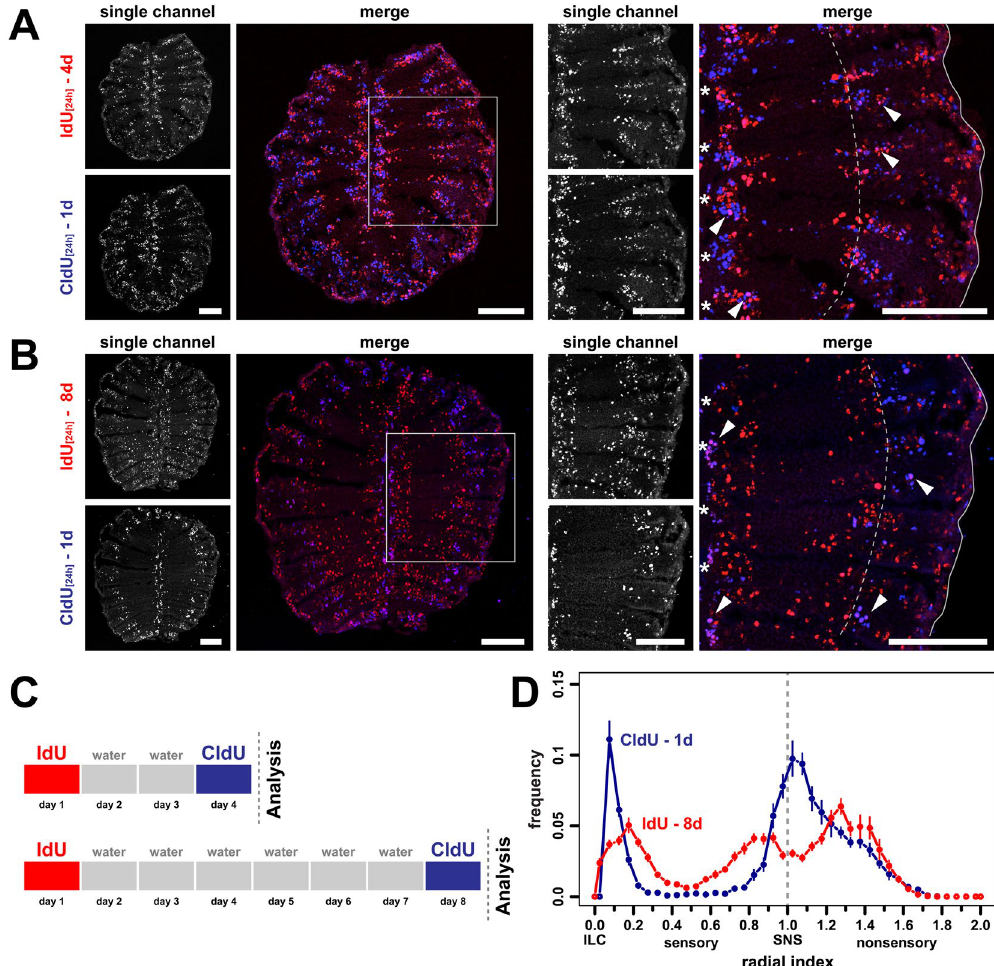
Figure 3. Simultaneous labeling of old and young cell populations in the same olfactory epithelium. ( A ) Cross sections through the OE of fish that were incubated with IdU (red) for 24 h followed by a second 24 h incubation with CldU (blue) two days later. Single channel exposures are shown to the left, the merged channels to the right. The panel on the right shows a higher power view of one side of the OE indicated by the grey box on the left. Single IdU- and CldU-positive cells as well as double positive cells (pink, arrowheads) can be detected. The younger CldU-positive and CldU/IdU double positive cells are confined to the interlamellar curves (asterisks) and regions peripheral to the sensory/nonsensory border (dotted line). The older single IdU-positive cells occupy more central positions in the sensory OE. Scale bars: 100 µ m. ( B ) Same experiment as in A. but with a 6d time interval between consecutive labelling with IdU and CldU. IdU single-positive cells advanced further from the ILC and SNS towards the centre of the sensory epithelium. Scale bars: 100 µ m. ( C ) Schematic representation of the experimental setup for A. (top) and B. (bottom). ( D ) Frequency distributions of IdU- (red) and CldU (blue) single-positive cells from the 8d experiment shown in B. The positions of cells were normalized to the length of the sensory OE between the interlamellar curves (ILCs) and the sensory/ nonsensory brder (SNS). The dotted line indicates the position of the SNS. The older IdU-labeled cells show a broader, more central distribution than the younger CldU-positive cells that are concentrated at the ILC and SNS. The graph represents the positions of 4.787 IdU-positive and 3.778 CldU-positive cells from 20 sections of 2 fish, mean ±